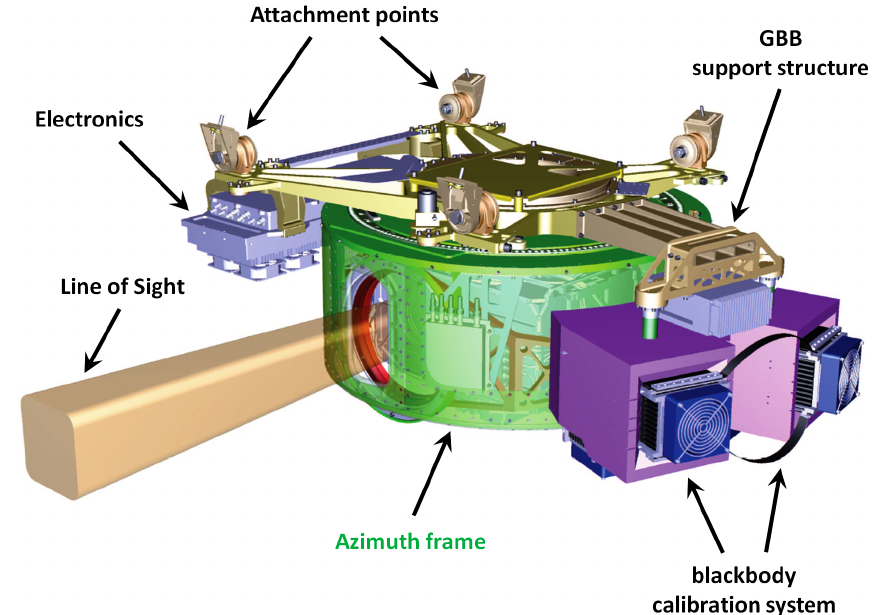
Fig. 1. Gimbal mounted GLORIA instrument with in-flight blackbody calibration system.